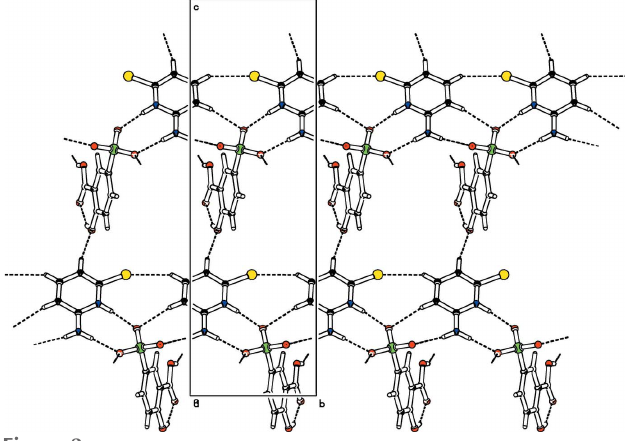
Figure 2 A packing diagram of the title compound, showing the hydrogen-bonded network (dashed lines).